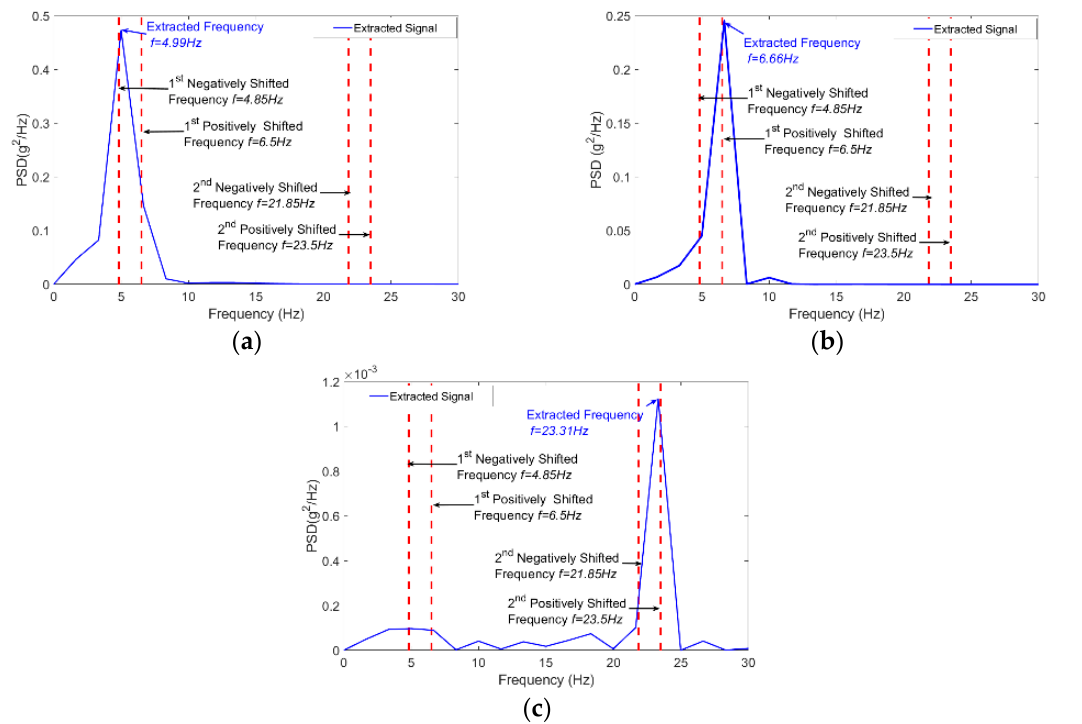
Figure 12. Extracted Signals PSD ( a ) first peak at f = 4.99 Hz, ( b ) second peak at f = 7.12 Hz, ( c ) third peak at f = 23.41 Hz.